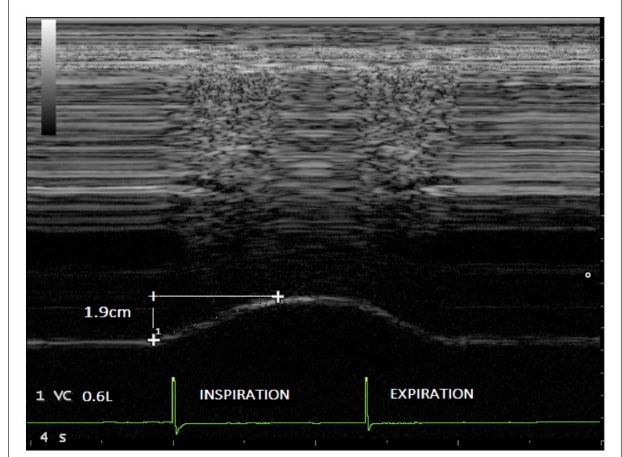
FIGURE 3 | Diaphragmatic excursion recorded in one volunteer during breathing at tidal volume (0.6 l) without load (1.9